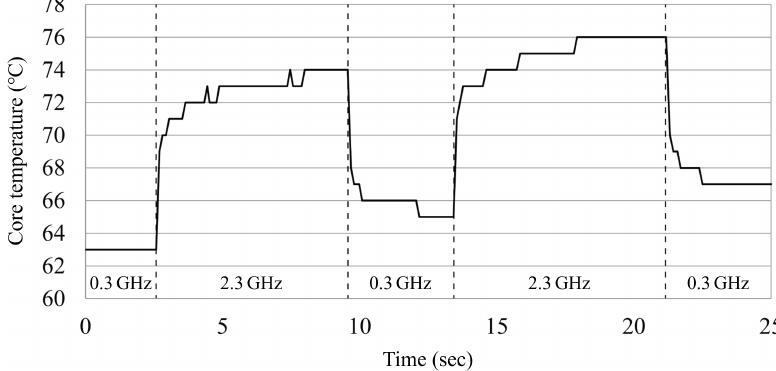
Figure 8. Thermal jumps and drops while adjusting the core frequency between f min to f max .